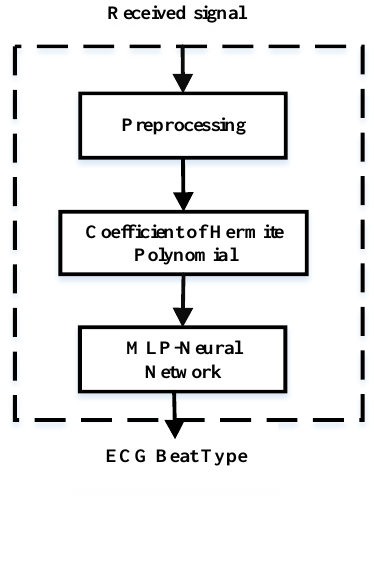
Figure 1. General scheme of the proposed